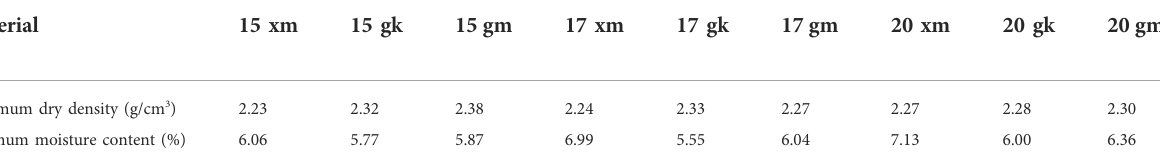
TABLE 1 Results of the maximum dry density and optimum moisture content.